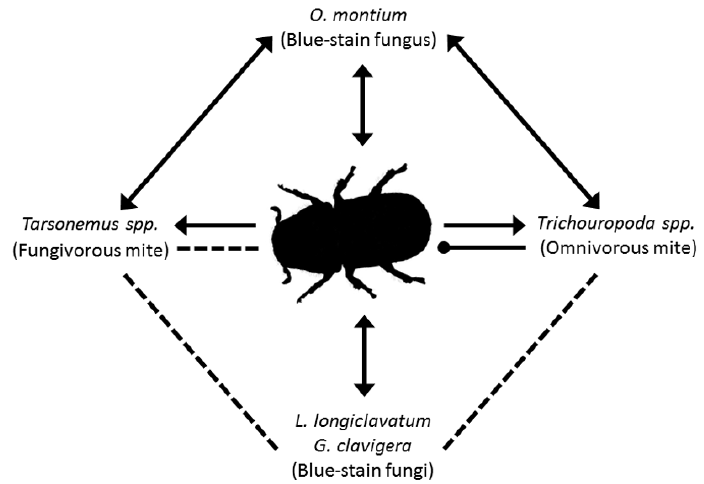
Figure 6. The interactions between the mountain pine beetle (MPB) phoretic and hyperphoretic fungi transported by mites. This illustration presents a hypothetical range of interactions among a phoretic fungivorous and an omnivorous mite genus in the horizontal axes and among the three blue-stain fungi in the vertical axes and the MPB. The transverse lines indicate the interactions among the blue-stain fungi and the two common mite genera found during the decline of an MPB population. The arrows point to the affected organism in the relationship and the sign indicates the type of effect. The solid lines indicate a direct effect and the dotted lines indicate an indirect effect of the